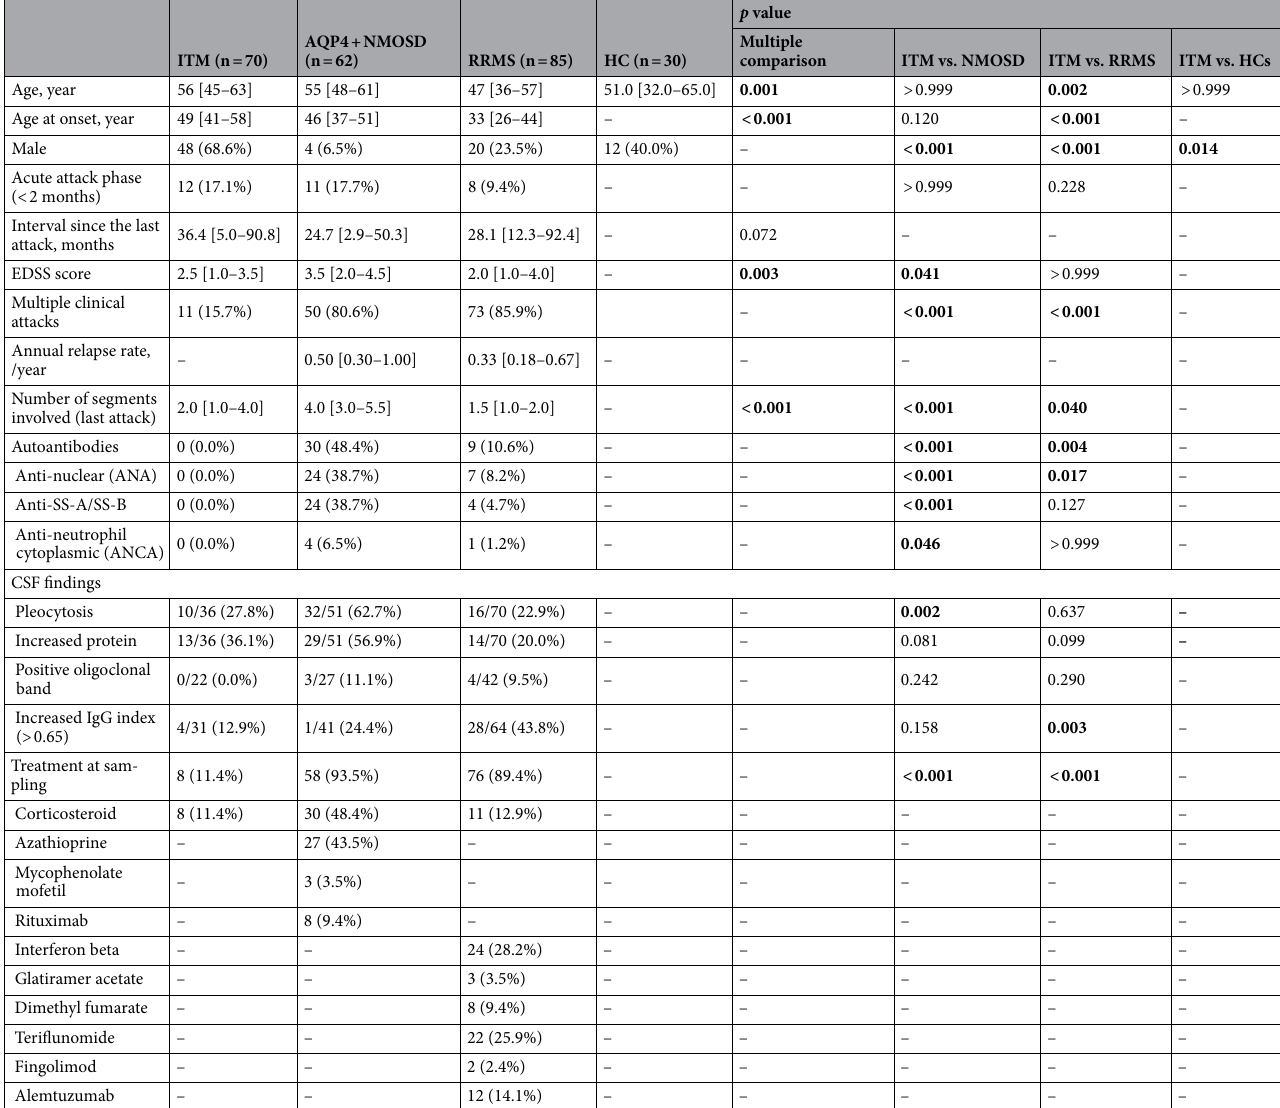
Table 1. Demographic and clinical features of patients and healthy controls. Values represent medians with interquartile ranges or counts with percentages. p values for pairwise comparisons are demonstrated only for ITM-including pairs. p values with statistical significance ( p < 0.05) are presented in bold. ITM: idiopathic transverse myelitis; AQP4 + NMOSD: aquaporin-4 antibody-positive neuromyelitis optica spectrum disorder; RRMS: relapsing–remitting multiple sclerosis; HC: healthy control; EDSS: Expanded Disability Status